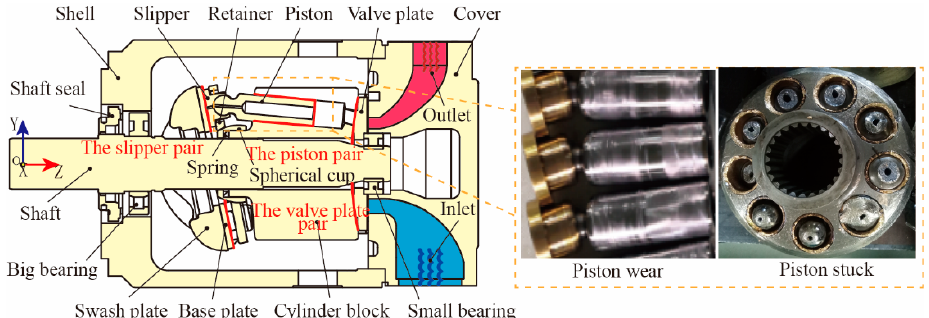
Figure 1. Typical structure and piston wear of axial piston pumps.